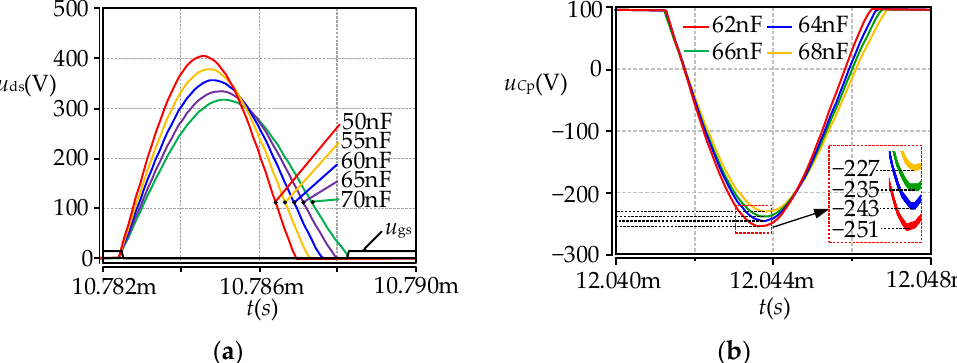
Figure 11. The waveforms of u ds and u C p versus C p values in Saber simulation. ( a ) The waveforms of u ds versus C p values; ( b ) the waveforms of u C p versus C p values.